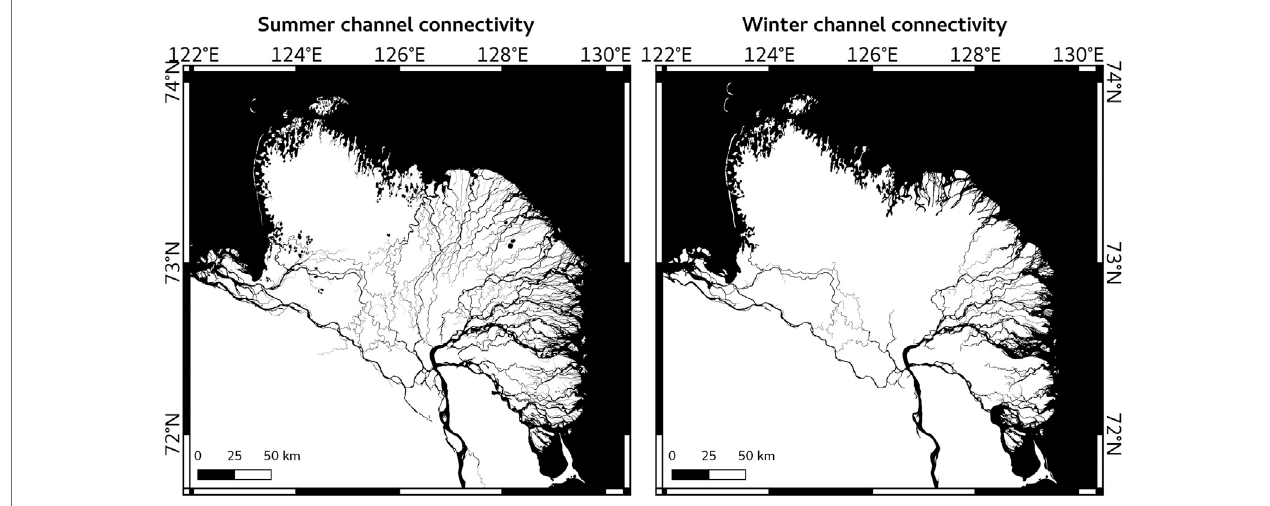
FIGURE 9 | Track of a ship (red line) navigated in summer 2016 along the Olenekskaya Channel toward the western part of the Laptev Sea. A SAR-based map of serpentine ice was used for navigating along the deep parts of the channel, surrounded by extreme shallows ( < 1 m).